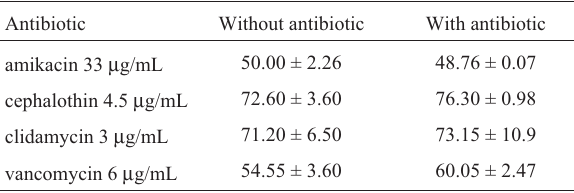
Table 2 - Effect of in vitro administration of amikacin, cephalothin, clindamycin and vancomycin on viability of fibroblasts.